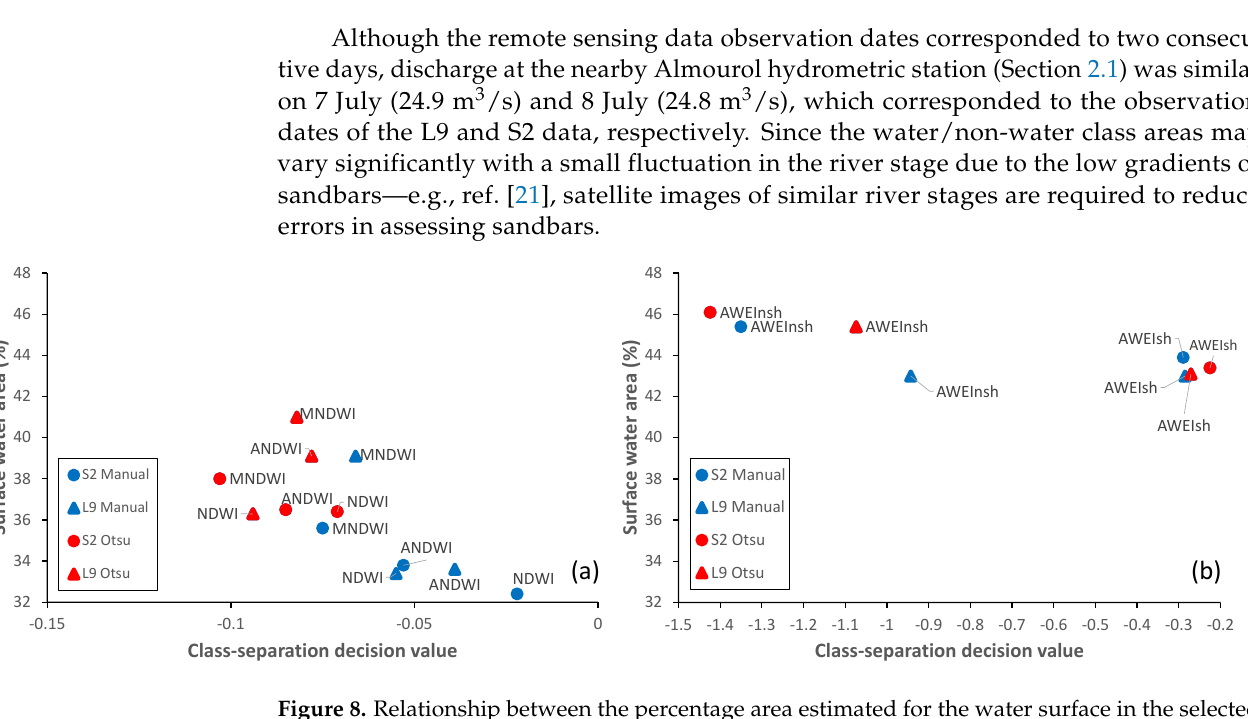
Figure 7. Comparison of classification results obtained for the NDWI, MNDWI, ANDWI, AWEIsh, and AWEInsh calculated from Sentinel-2 (S2) and Landsat 9 (L9) data, applying manual decision and the minimum within-class variance (Otsu method) criterion: ( a ) J–M distance found for the class segmentation decision values; ( b ) water surface percentage area in the studied segment of the Lower Tagus River (Portugal). The classes are for water and non-water (i.e., sandbars) surfaces. The 1:1 line is shown for reference. The remote sensing data spatial resolution is 20 m for S2 (8 July 2022) and 30 m for L9 (7 July 2022), for similar discharge conditions.